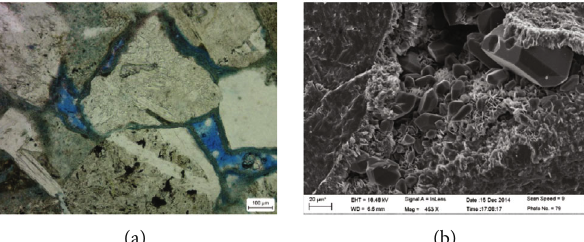
Figure 3: (a) Porous lining chlorite surrounds the intergranular pores, and the pores are fi lled with microcrystalline quartz, B202 well, 3117.80m (-). (b) Porous lining chlorite surrounds the intergranular pores, and the pores are fi lled with microcrystalline quartz, B202 well, 3098.9m,